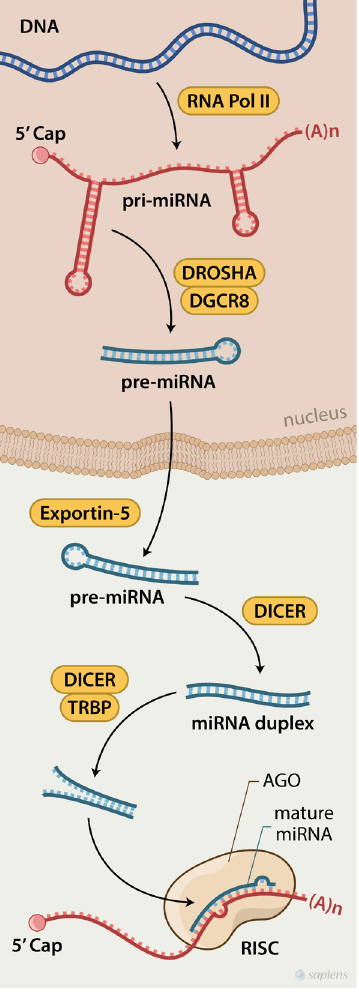
Figure 2. The miRNA processing pathway. Schematic representation of the mechanism of synthesis and processing of miRNAs in mammalian cells. Primary miRNA transcripts (pri-miRNA) are synthesized by RNA polymerase II, many of them corresponding to intronic regions or clusters of miRNAs. Pri-miRNAs are processed in the nucleus by the microprocessor complex (containing DROSHA and DGCR8), or by components of the splicing machinery (not depicted in the figure), for the generation of miRNA precursors (pre-miRNAs). These molecules are then exported to the cytoplasm by Exportin-5 and recognized there by DICER. DICER cleaves the pre-miRNAs and with the help of TRBP gives rise to mature miRNA molecules, which then recognize their target mRNAs and recruit the RNA-induced silencing complex (RISC) to mediate the silencing process (i.e., inhibition of translation and/or mRNA decay) through the action of Argonaute proteins (AGO) such as